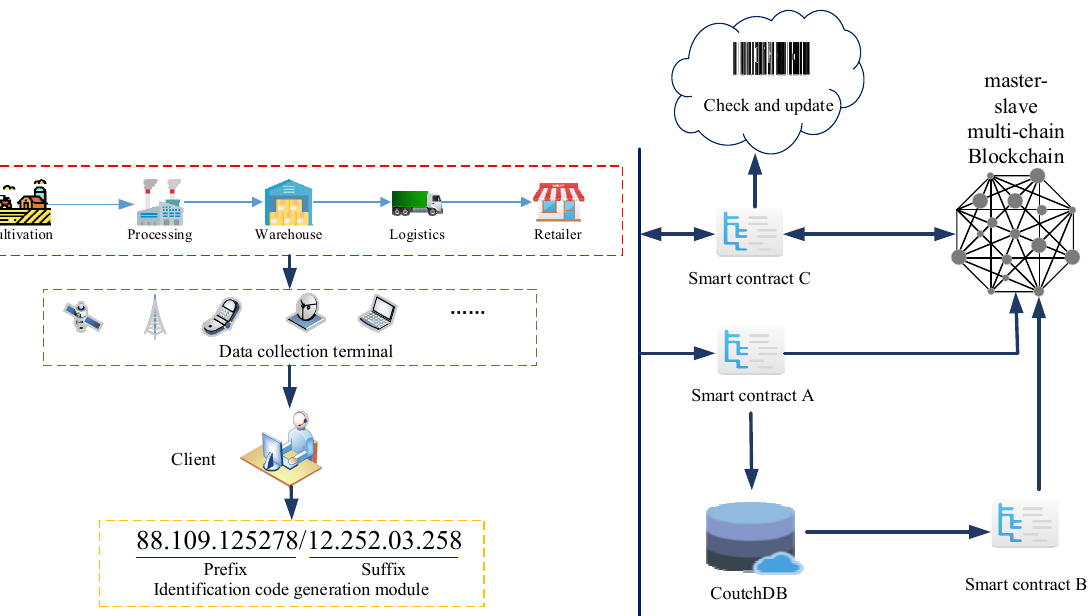
Figure 2. Schematic diagram of the model frame.